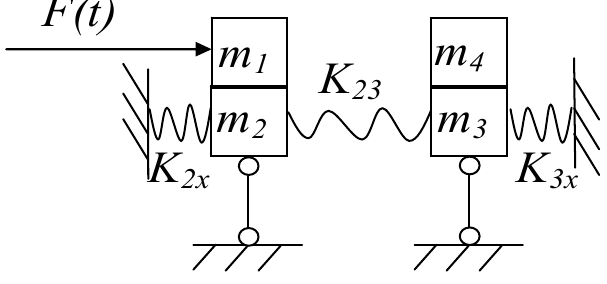
Figure 15. Horizontal vibration model.